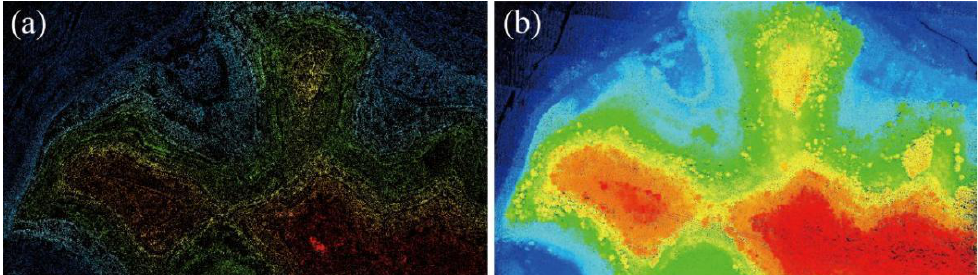
Figure 3. The points cloud processed by Terrasoil without vegetation and buildings to generate DEM ( a ), and the original point cloud extracted by UAV images ( b